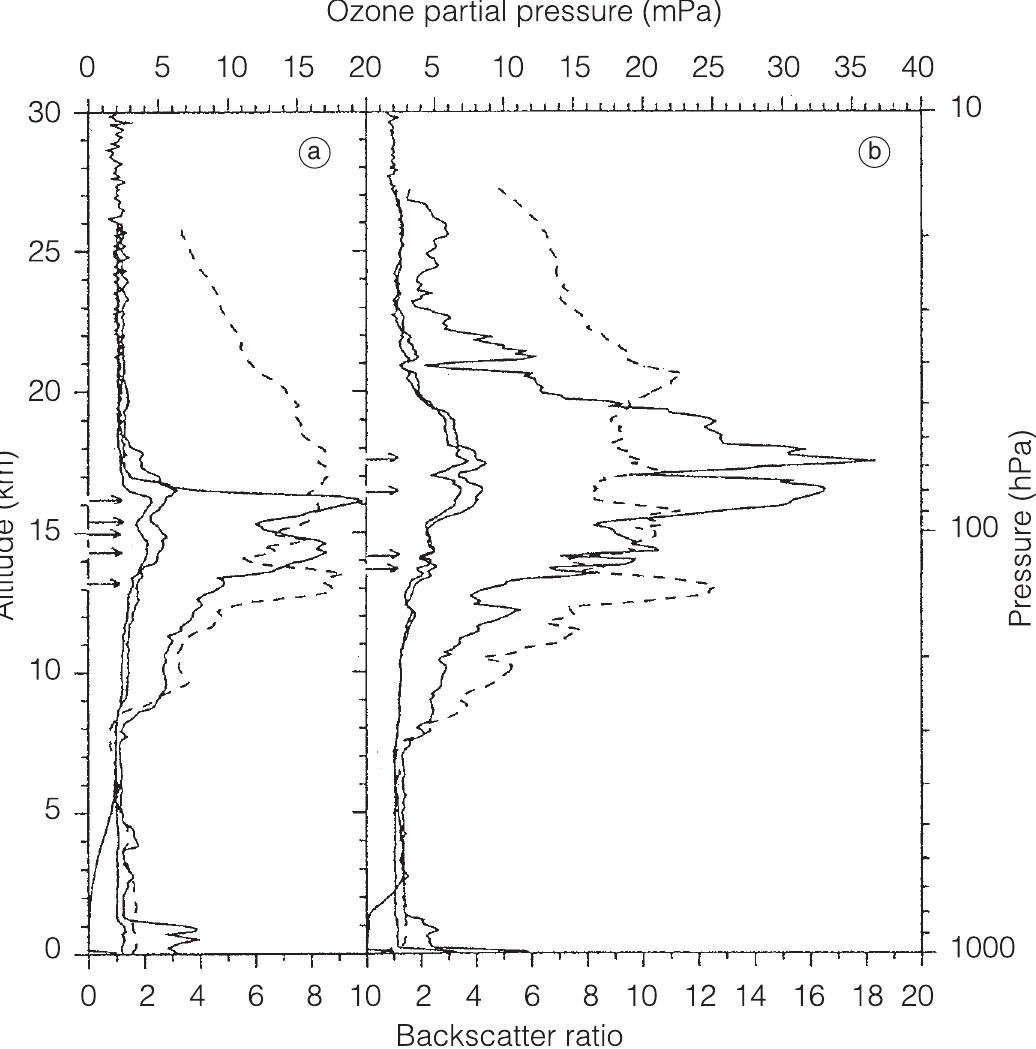
Fig. 8a,b. a) Vertical profi les of aerosol backscatter ratio in three wavelengths (solid lines) and ozone partial pres- sure (dashed) from 23 January 1992, when Thule was inside the polar vortex. b) Observations on 5 February, when Thule was outside the polar vortex. The lidar backscatter profi le is intermediate between the 940 nm (large values) and 480 nm sonde profi les. The arrows indicate layers where parameters of size distributions have been derived. The tropopause is located at 8 km where the ozone pressure increases sharply. The pressure scale is approximate (Larsen et al. ,